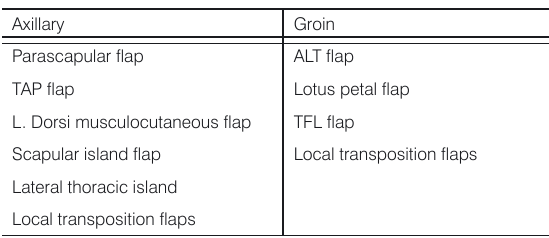
Table 2. Flap alternatives for the axilla and groin